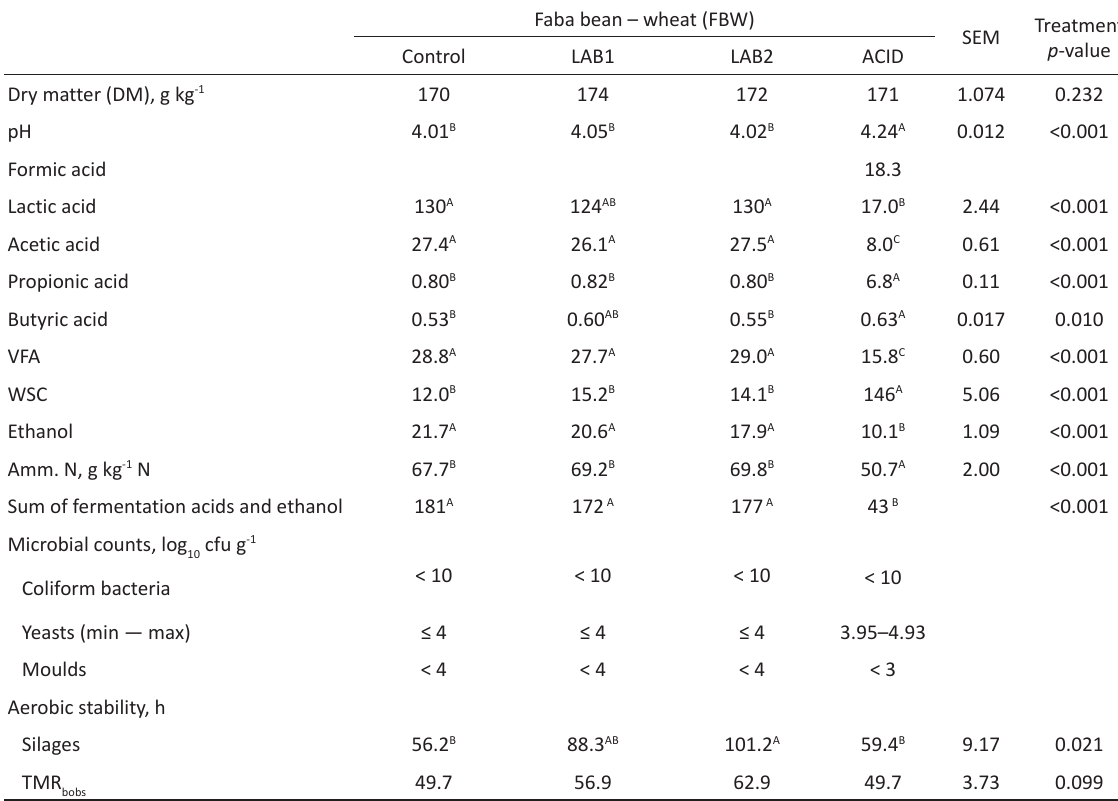
Table 3. Fermentation quality (g kg -1 DM) and aerobic stability of the Faba bean – wheat (FBW) silages and